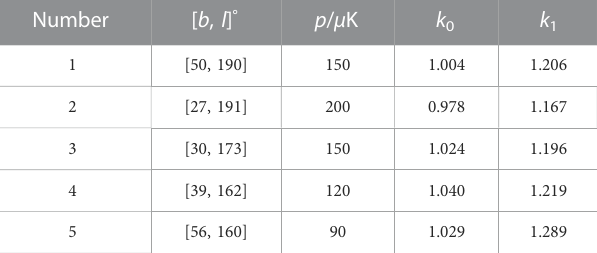
TABLE 2 Derived fi tting parameters for multiple point sources by the multi- linear regression method when the polarization direction is known for each point source, which are comparable with those for each single point